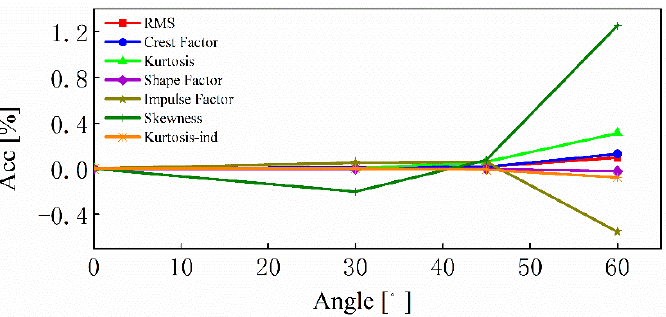
Figure 23. Variation of percentage of statistical index with different crack depths.